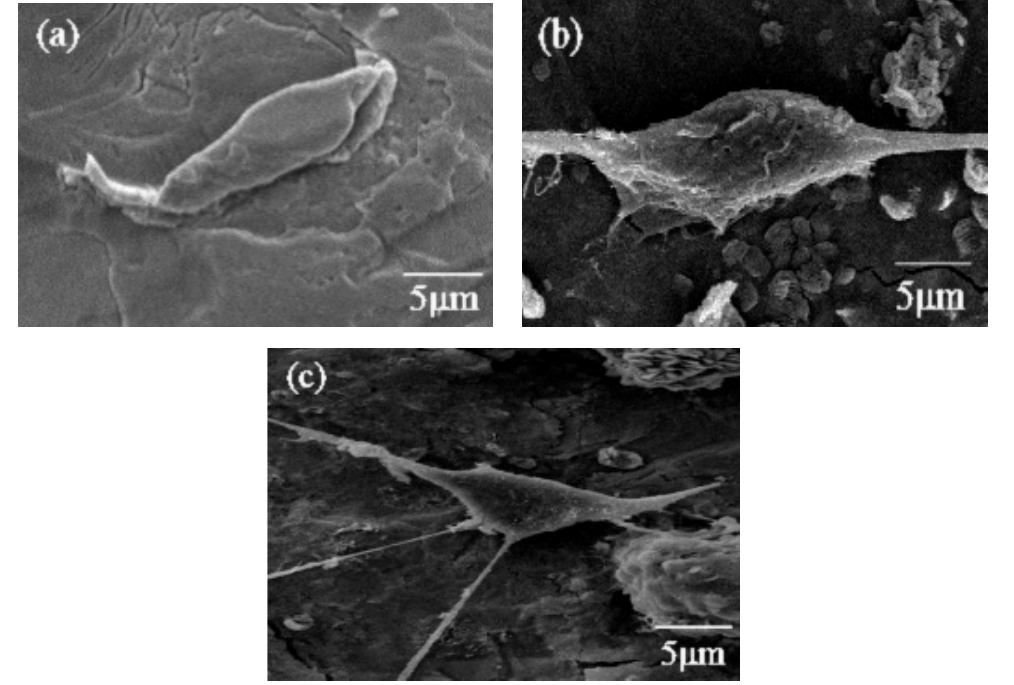
Figure 8. SEM images of preosteoblast MC3T3-E1 cells growing on each sample after 24 h of incubation: ( a ) bare Ti; ( b ) HA coating; and ( c ) HA-CNT/TiO was heat-treated at 450 °C for 1 TiO 2